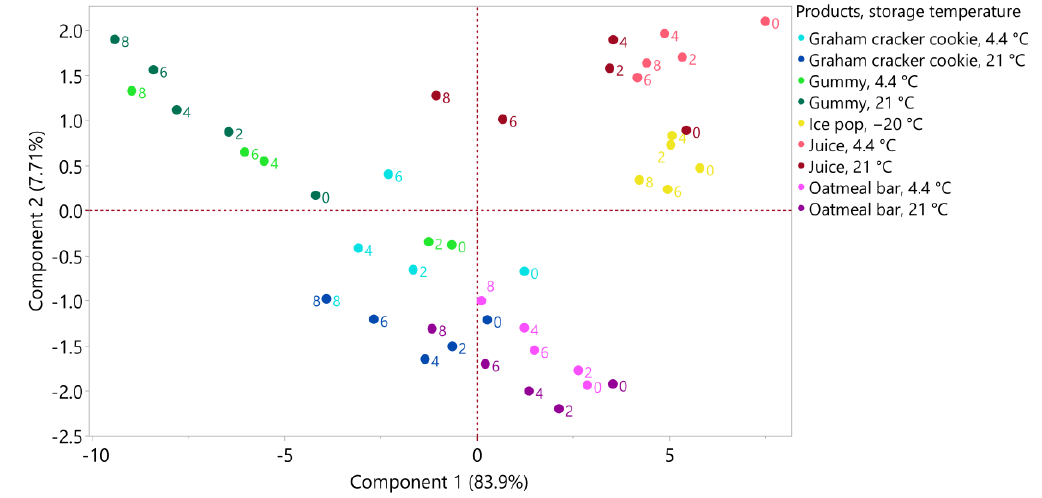
Figure 3. Principal component analysis (PCA) scores plot of blueberry products stored at − 20 °C (ice pop), 4.4 °C and 21 °C (graham cracker cookie, gummy, juice, oatmeal bar) for 0, 2, 4, 6, and 8 weeks ( n = 3/time point).